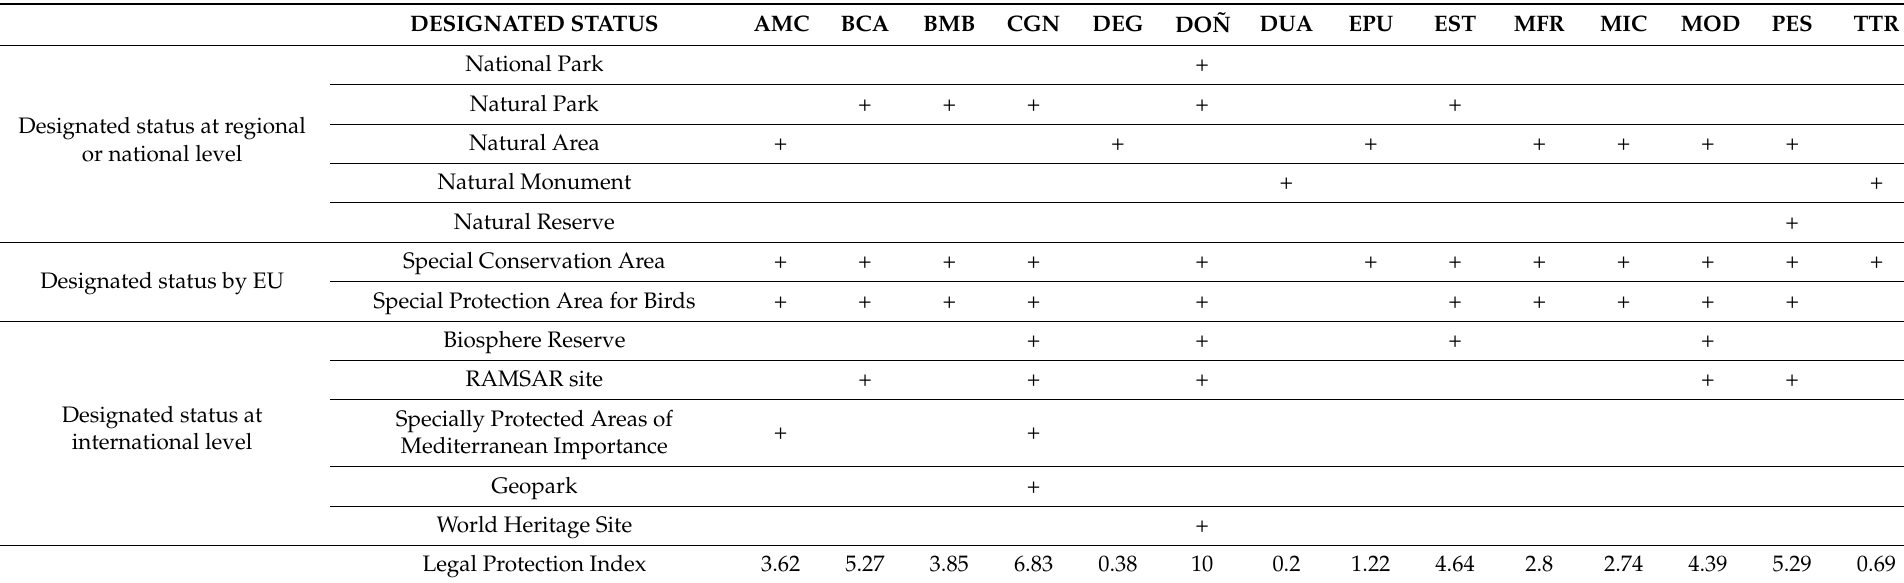
Table 3. Protected status of each Protected Area studied and Legal Protection Index value [24]. DESIGNATED STATUS